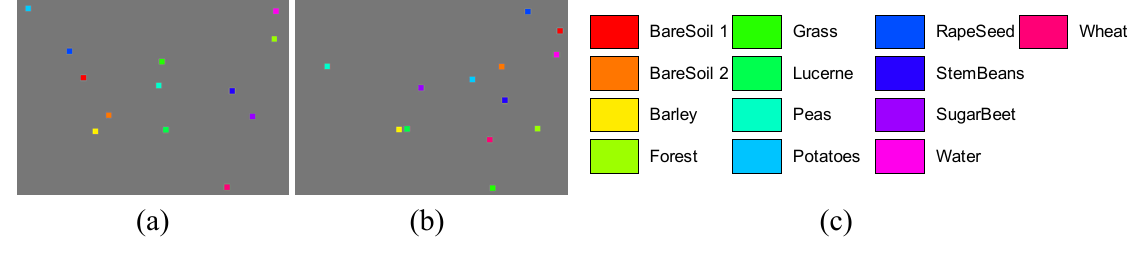
Table 6. Sample numbers of training and test area.